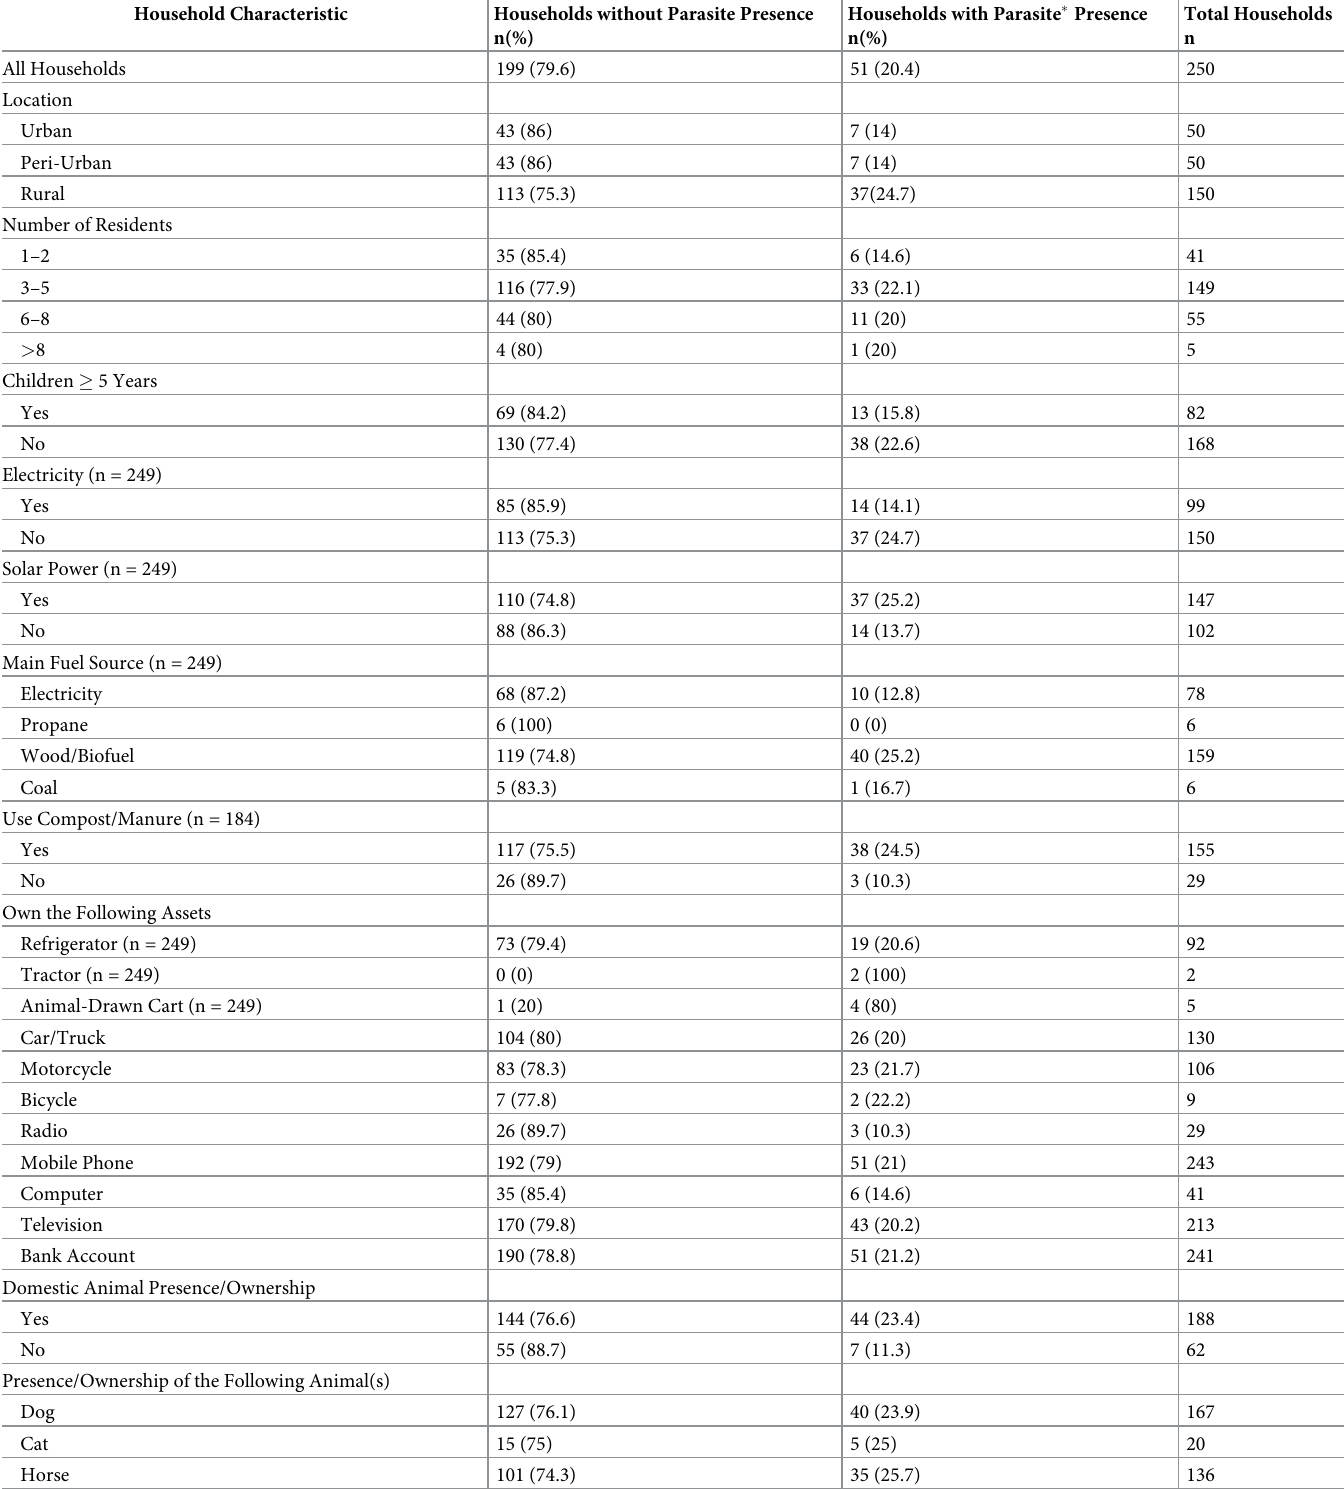
Table 2. Characteristics of Mongolian Households with Zoonotic Enteric Parasite Presence (n = 51) and Without (n = 199). Household